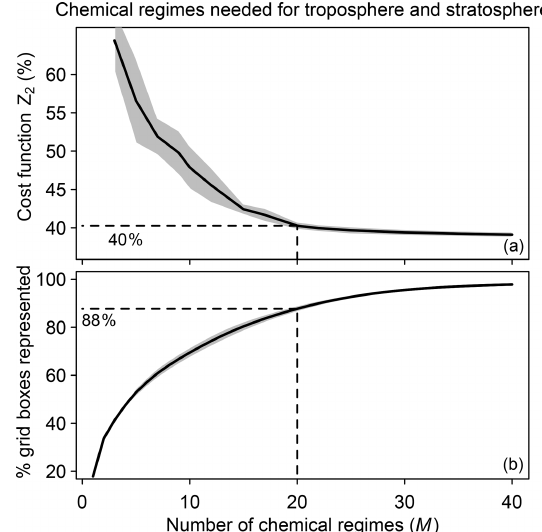
Figure 3. Speedup of the chemical computation as a function of the number M of chemical mechanism subsets (chemical regimes) used in the coupled implicit solver of the GEOS-Chem model for adap- tive simulation of the troposphere and stratosphere. (a) Minimum of cost function Z 2 (global fraction of chemical species treated as fast) as a function of the number of chemical regimes. (b) Percent- age of model grid boxes that can be represented by the M chemical regimes without adjustment (see Eq. 5 and related text). Dashed lines show the values for M = 20. For both panels, results are for the first 10d of February, May, August, and November sampled ev- ery 6h (shaded area denotes 1 standard deviation of results sampled every